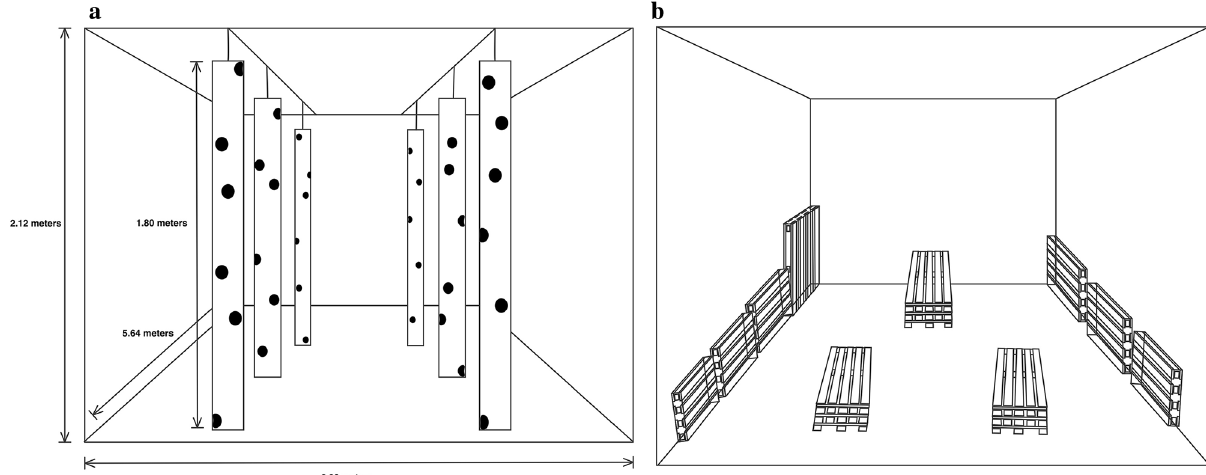
Figure 3. ( a ) The laboratory during the semi-field condition and experiment two. Six truncated trees [European aspen ( Populus tremula ), European mountain ash ( Sorbus excelsior ), European ash ( Fraxinus excelsior) , Norway maple ( Acer platanoides ), goat willow ( Salix caprea ), white birch ( Betula pubescence ) and grey alder ( Alnus incana )] were drilled with 7–10 scent holes and hanged down from two railing systems. The trees could be moved alongside the railing systems. ( b ) The laboratory during semi-field condition and experiment two. Seven pallets stacked against the wall or three stacks of three